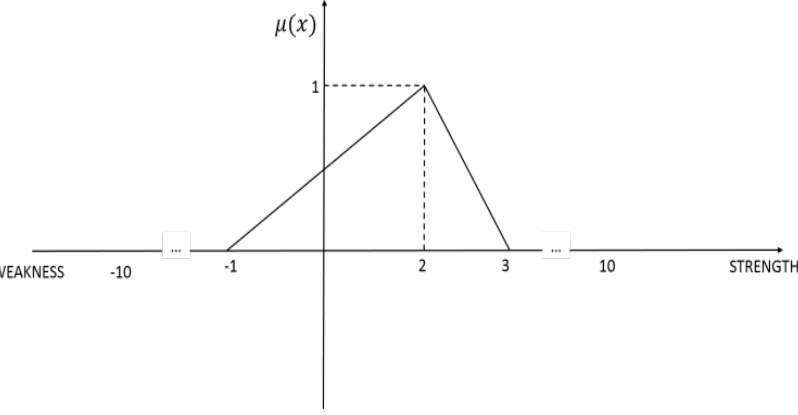
Figure 3. Example of triangular membership function for values { − 1 ,2, 3}.